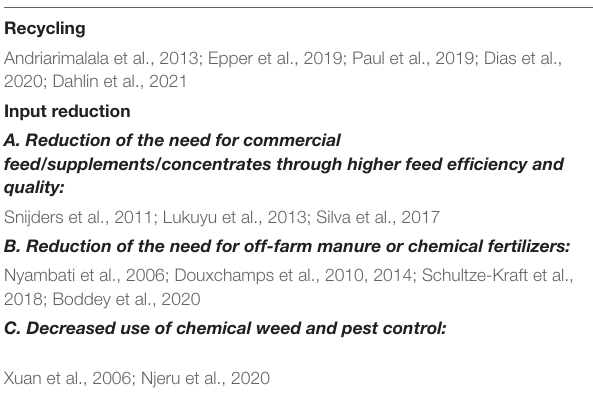
TABLE 1 | Key references describing the contribution of tropical forages in mixed crop-tree-livestock (MCTL) systems to the 13 agroecological principles described by Wezel et al.